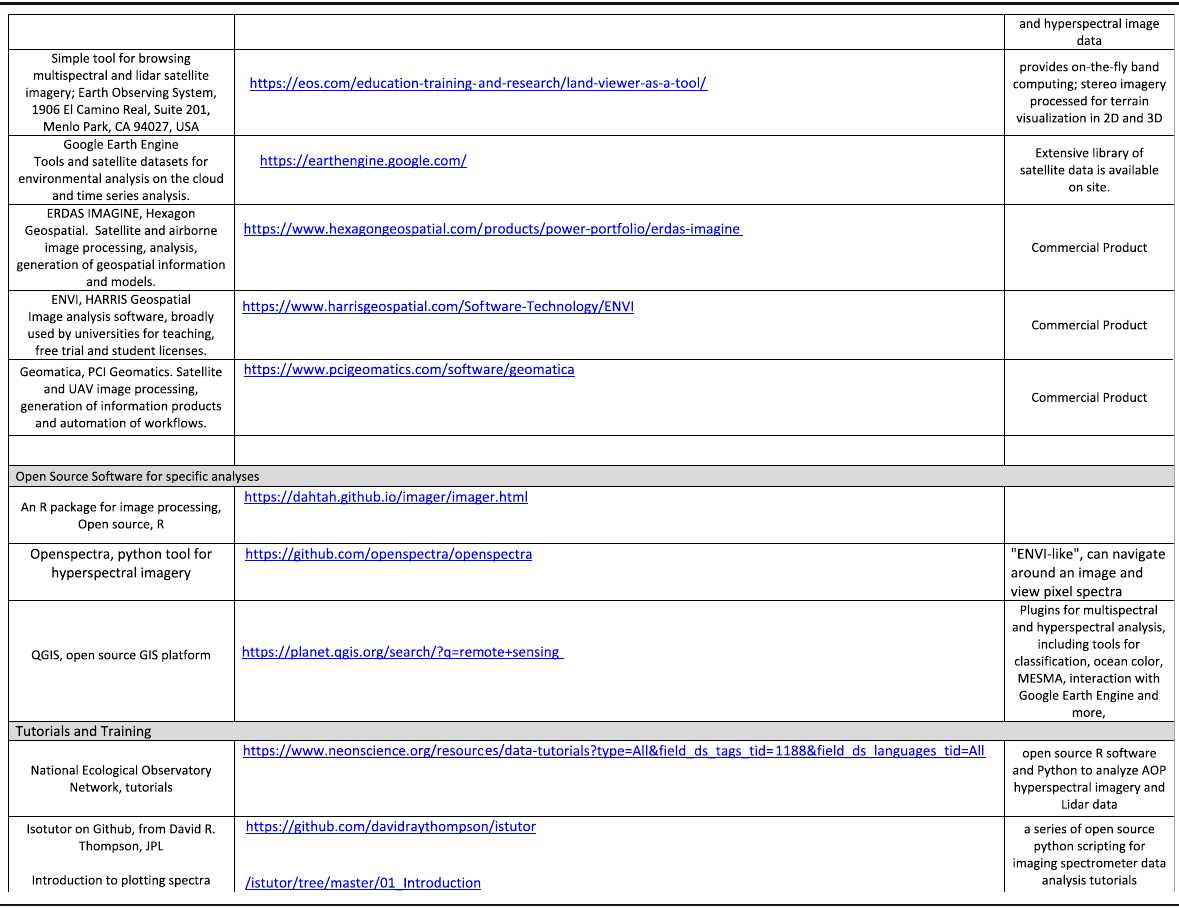
Table 7 Examples of Open Source Programs for Analyzing Satellite Data